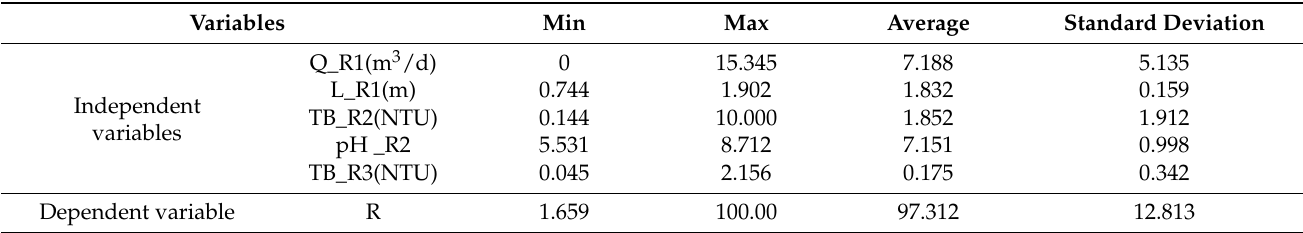
Table 3. Characteristics of the input